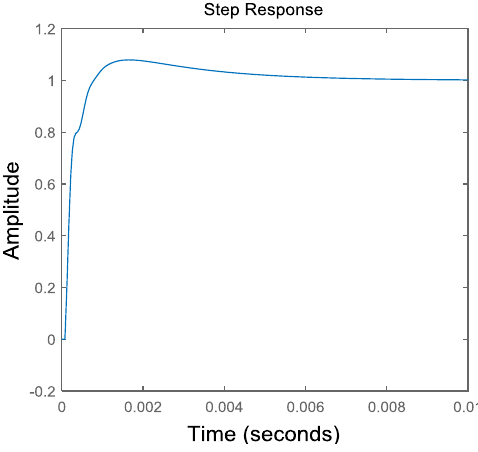
Figure 17. Step response of voltage closed-loop transfer function with set 1.